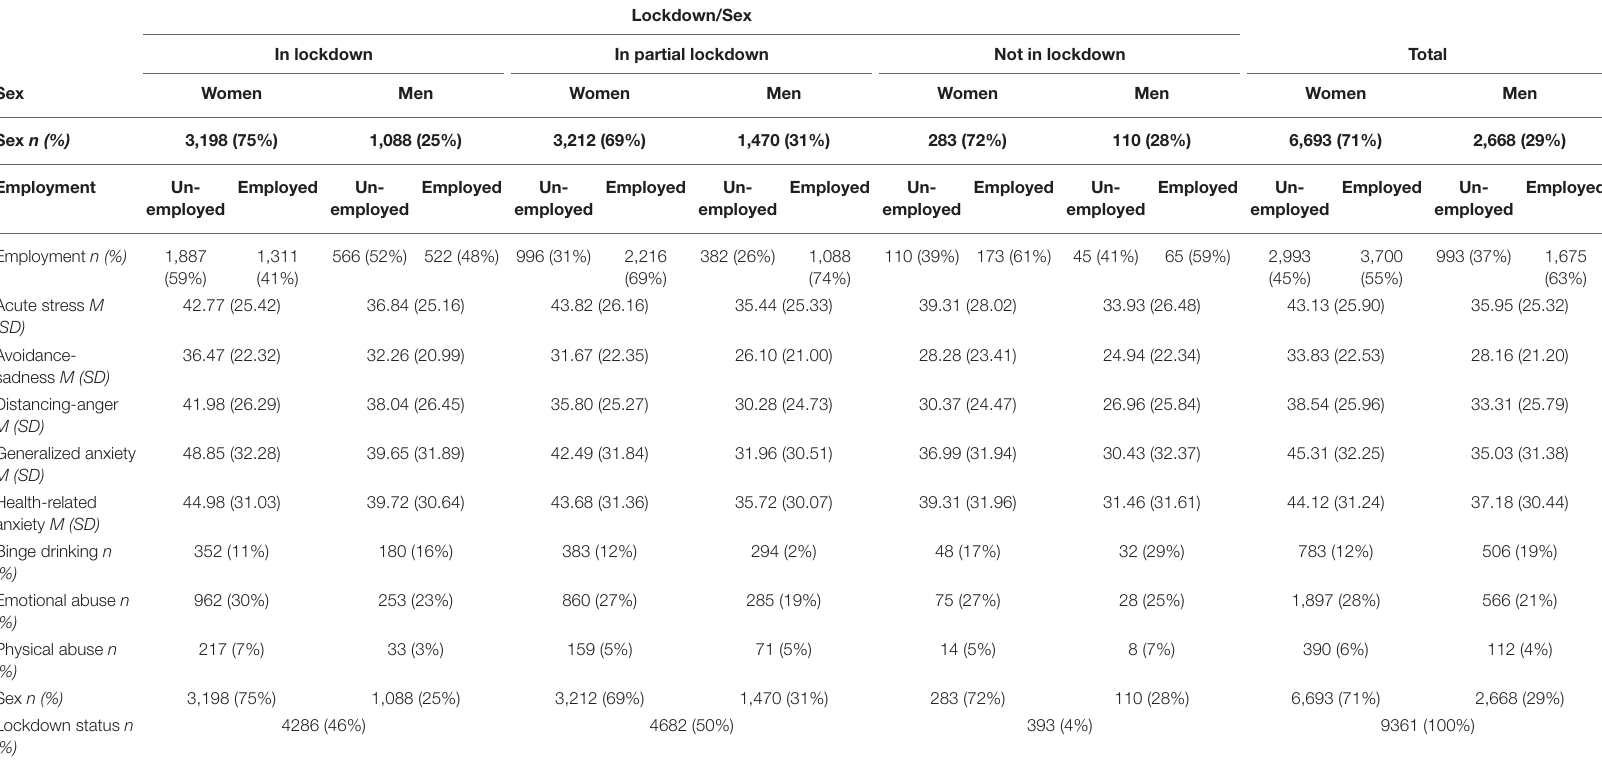
TABLE 1 | Number of respondents with lockdown status during the COVID-19 pandemic, gender, employment status, and clinical characteristics, including sex.